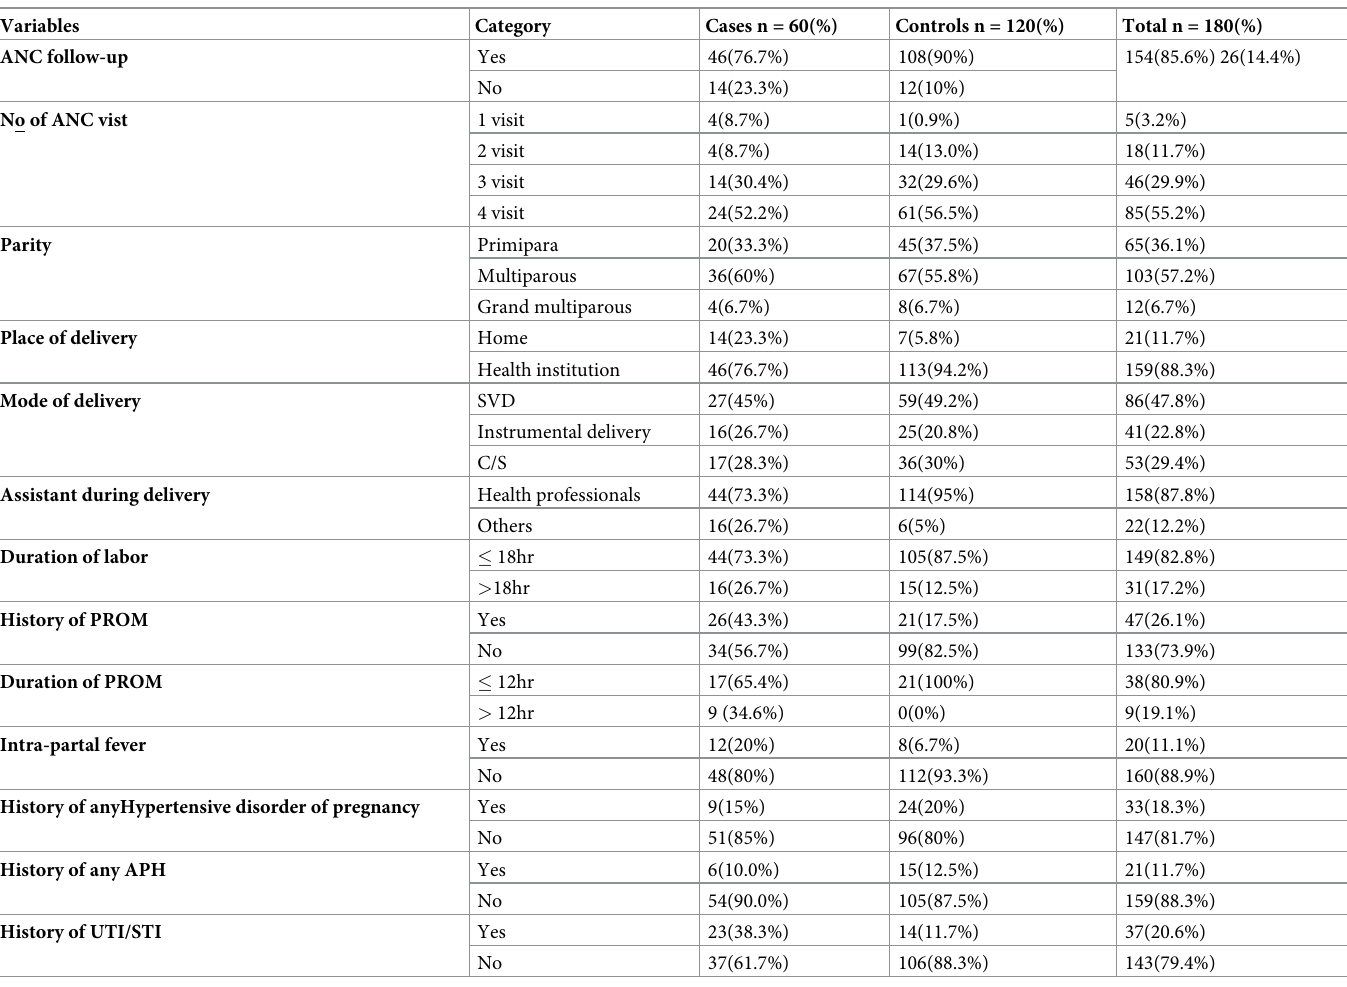
Table 2. Obstetric characteristics of mothers of the